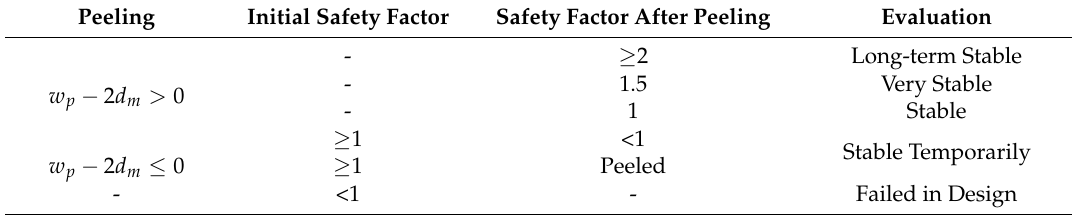
Table 7. Long-term stability evaluation and pillar design criterions.